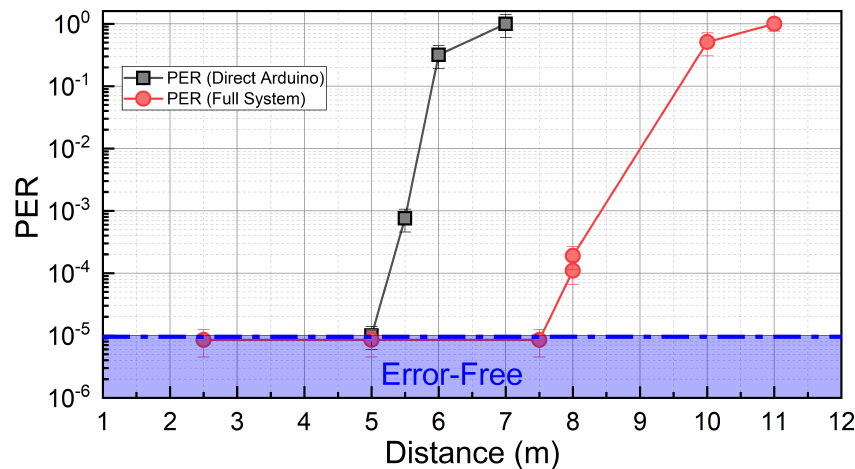
Figure 6. Outdoor tests: PER as a function of the distance between TX and RX, under a solar irradiance of 12,000 lux. Results were obtained with the traditional system (black) and the full sDR system